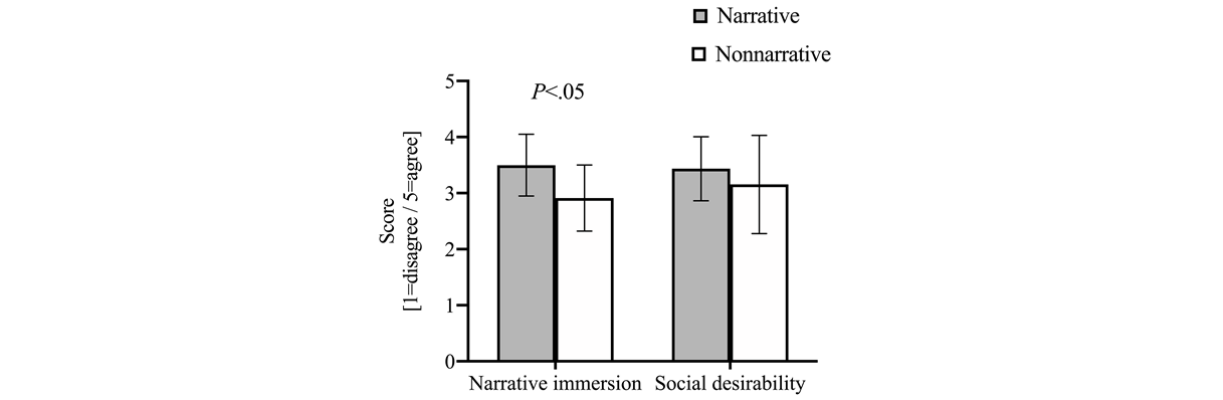
Figure 1. Comparison of narrative immersion between narrative videos and non-narrative videos adjusted by social desirability.